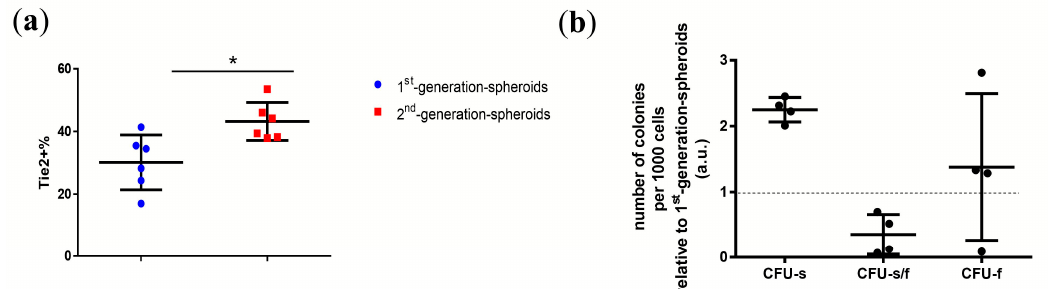
Figure 4. ( a ) Percentages of Tie2+ cell’s in whole human NPC population of 1st-generation spheroids and 2nd-generation spheroids; N (donors) = 6, Mann–Whitney U test, p = 0.0152. * = p -value < 0.05. ( b ) CFU-assay of NPCs suspended from 1st-generation spheroids and 2nd-generation spheroids, the number of clones per 1000 cells of 2nd-generation spheroids was expressed relative to 1st-generation spheroids. CFU-s stands for spheroid-like shape colonies, CFU-f stands for plastic-adherent fibroblast-like colonies, CFU-s / f represents colonies with a phenotype of mixed characteristics from CFU-s and CFU-f; “a.u.” refers to arbitrary units; N (donors) = 4. Lines in ( a , b ) represent means ± standard deviation (SD).